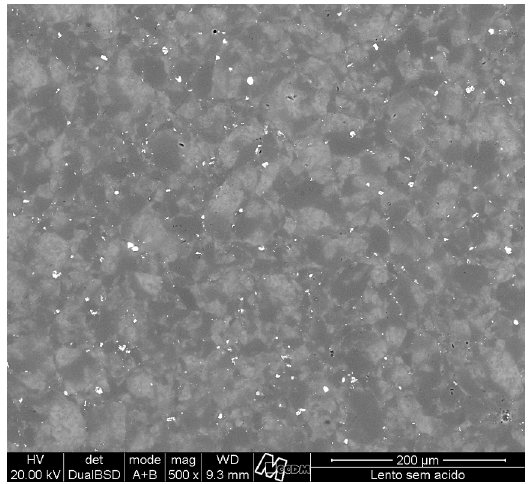
Figure 4. SEM images at 500 x magnification of Vita VM9 submitted to slow